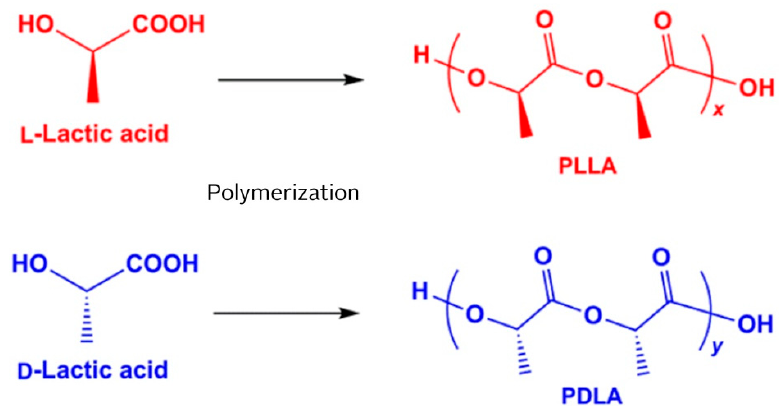
Figure 8. Poly(L-lactic acid) (PLLA) and poly(D-lactic acid) (PDLA) forms of polylactic acid (PLA).